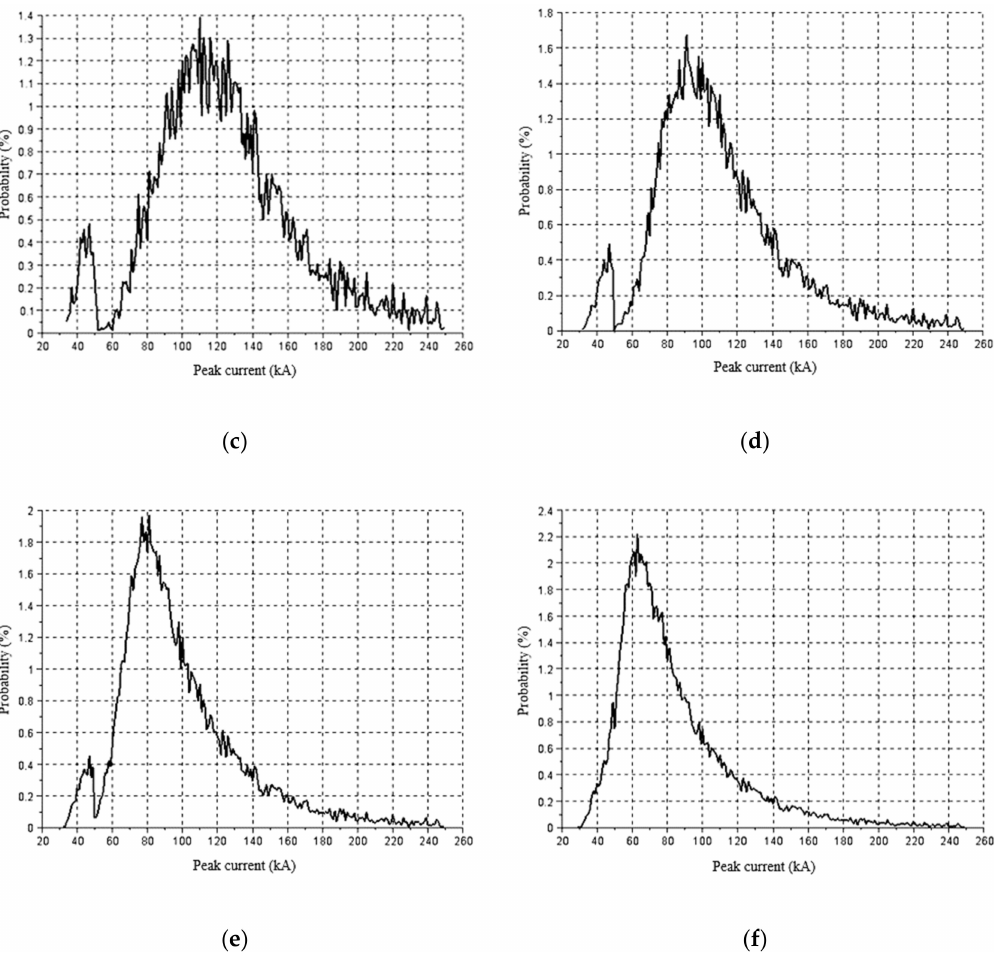
Figure 13. Probability distribution of the peak currents of N BFO flashes causing backflashover. ( a ) MT1 grounding arrangement, ρ g = 50 Ω m; ( b ) MT2 grounding arrangement, ρ g = 150 Ω m; ( c ) MT3 grounding arrangement, ρ g = 300 Ω m; ( d ) MT4 grounding arrangement, ρ g = 600 Ω m; ( e ) MT5 grounding arrangement, ρ g = 1300 Ω m; ( f ) MT6 grounding arrangement, ρ g = 2000 Ω